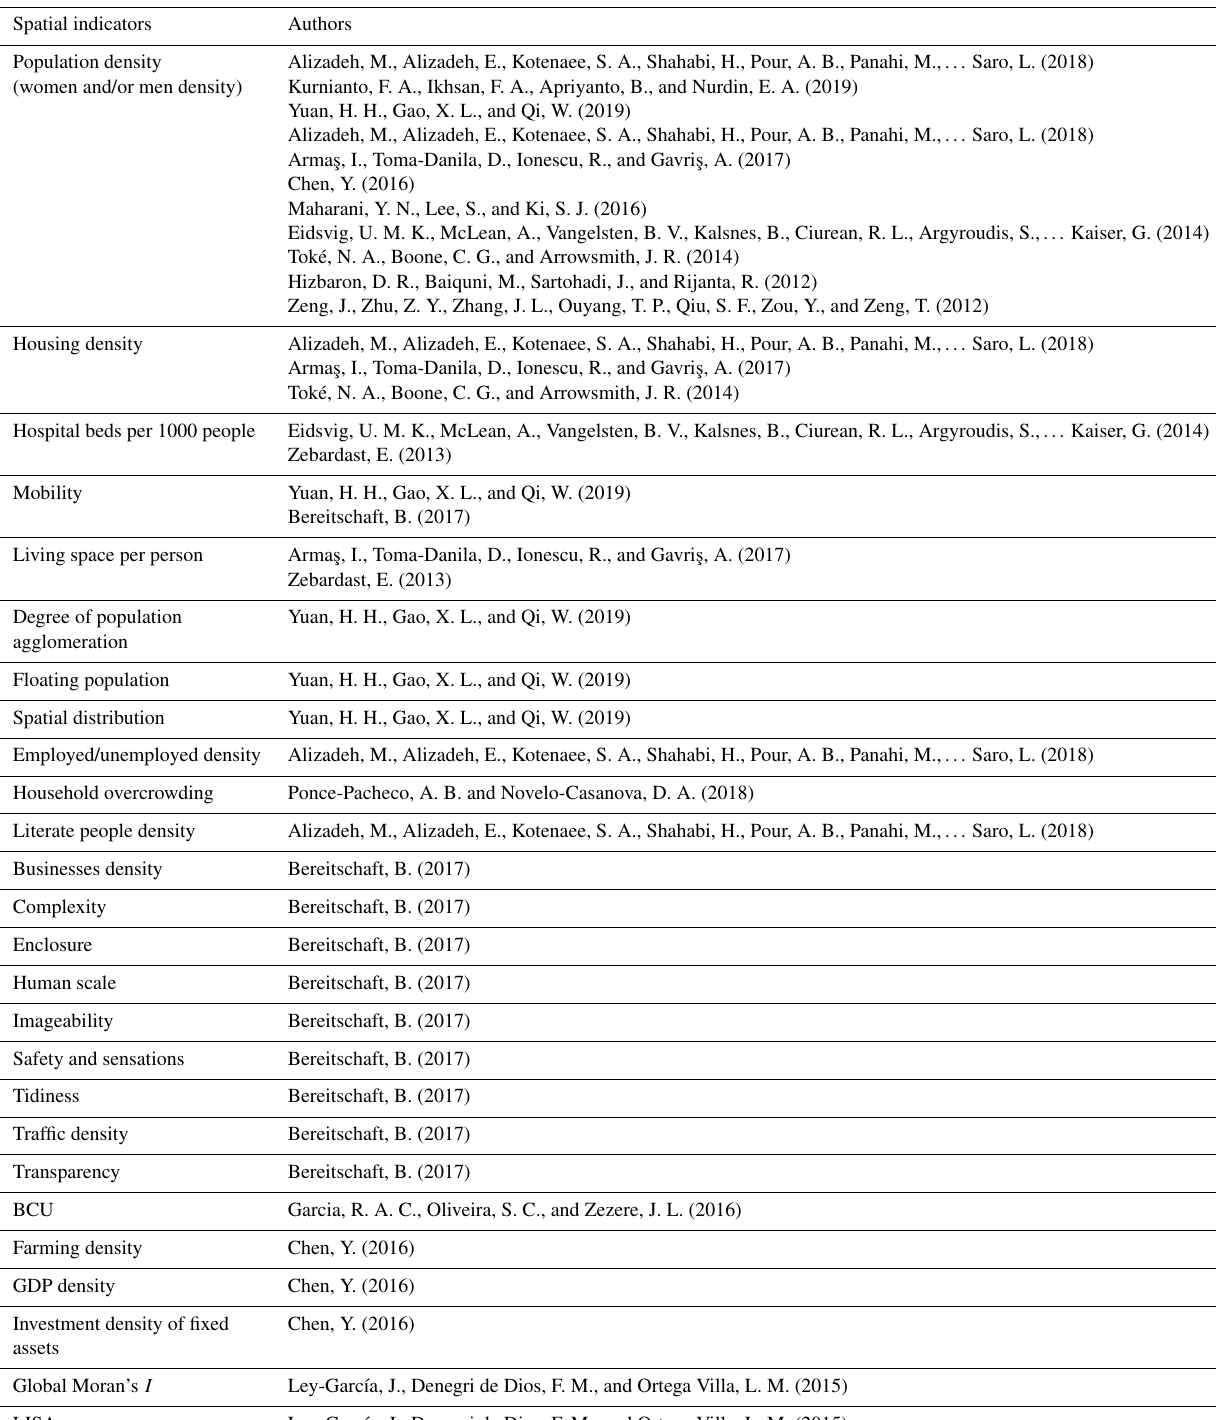
Table 5. Spatial indicators for socio-economic vulnerability